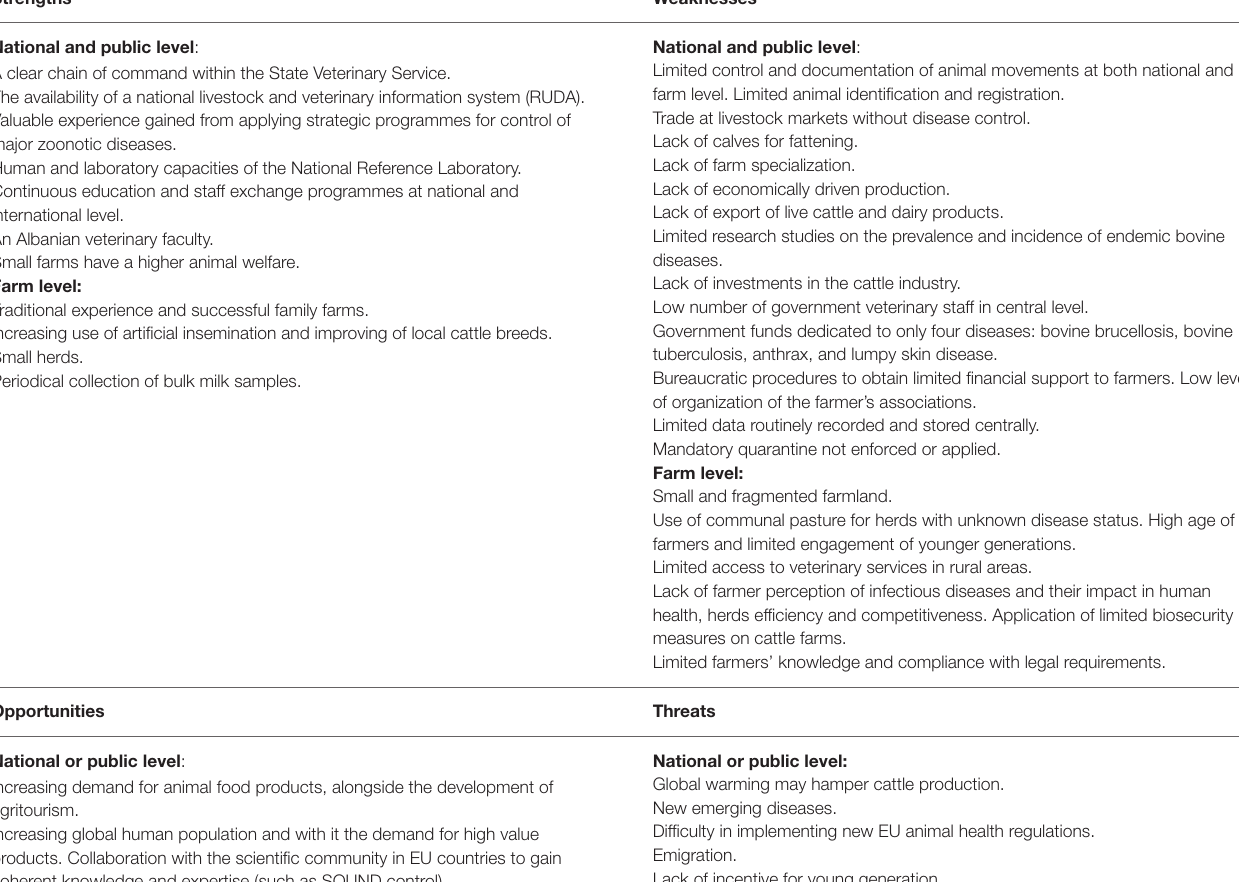
TABLE 1 | SWOT analyses considering cattle infectious disease control programmes in Albania.